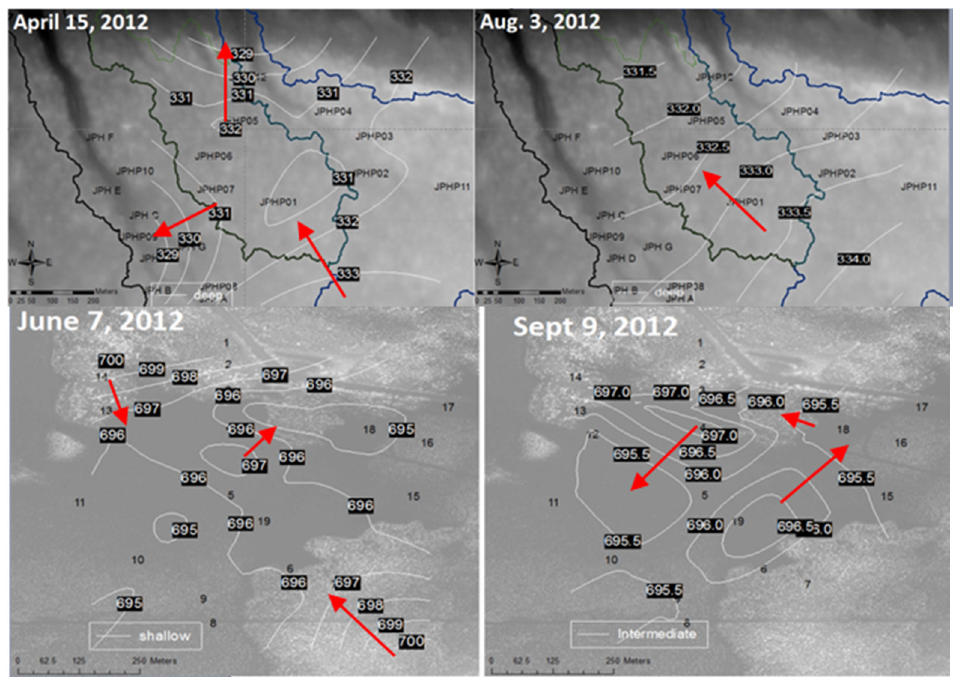
Figure 3. Maps showing hydraulic head elevations and inferred flow directions: for JPH ( top left ) April 2012, ( top right ) August 2012; and, for ML ( bottom left ) une 2012, and ( bottom right ) Sept. 2012.